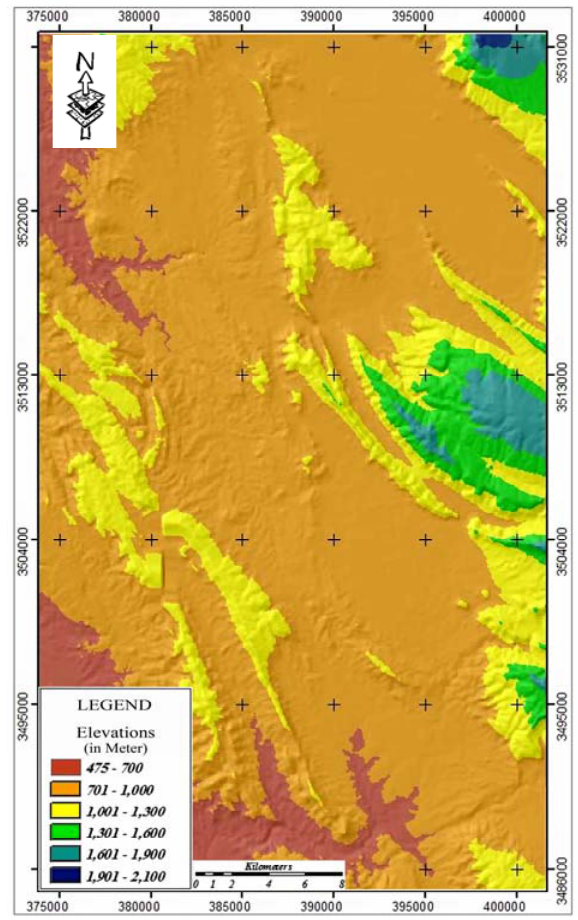
Figure 4. DEM of the study